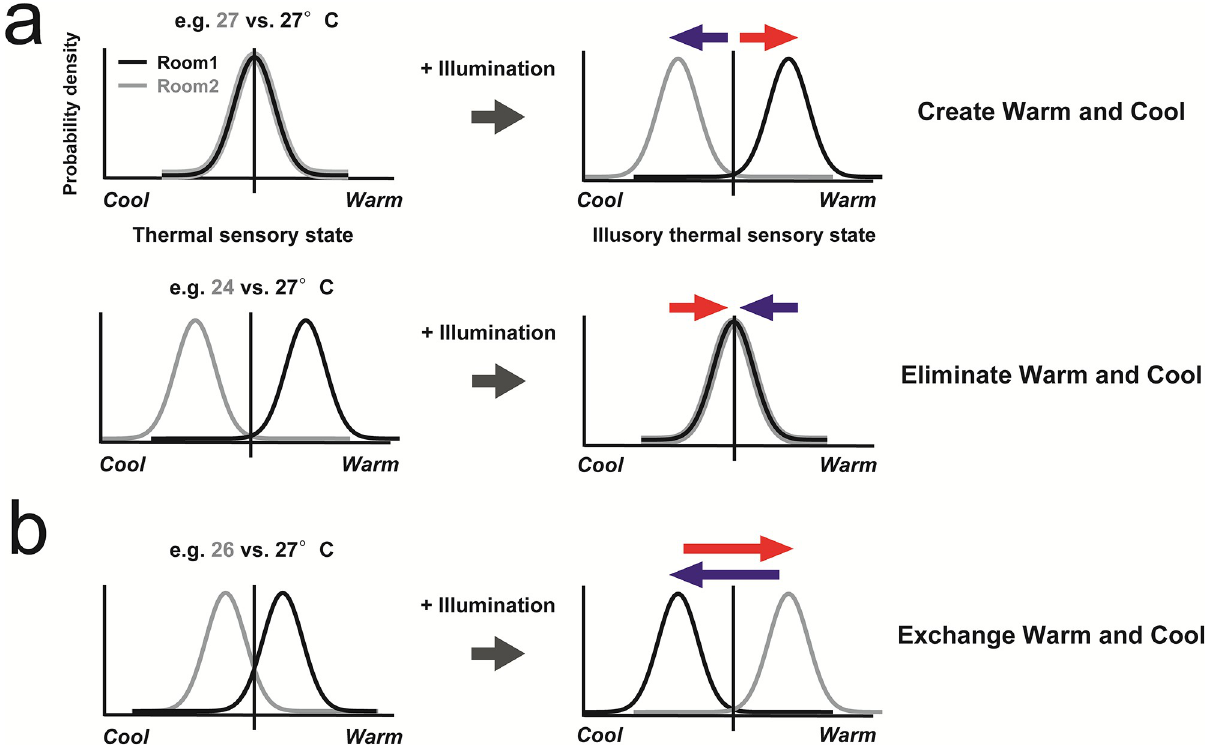
Fig 4. Thermal detection models of multisensory integration between perceived temperature and illumination (a) Top: Illumination creates warmness and coolness (See 27˚C vs. 27˚C condition in Fig 2). Bottom: Illumination eliminates warmness and coolness (See 25˚C vs. 27˚C or 24˚C vs. 27˚C in Fig 2). (b) Illumination exchanges warmness and coolness (see 26˚C vs. 27˚C in Figs 2 and 3).